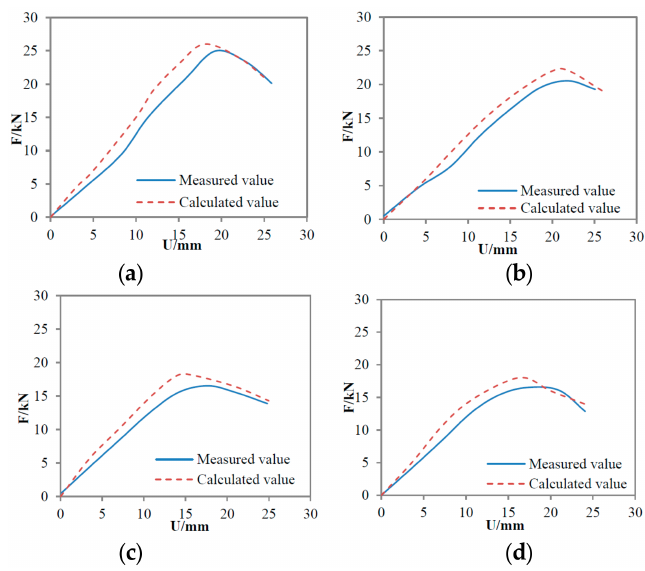
Figure 19. Comparison of calculated and experimental curves. ( a ) BD4-40-1; ( b ) BD4-40-2; ( c ) BD4-40-3; ( d ) PD4-40-3.